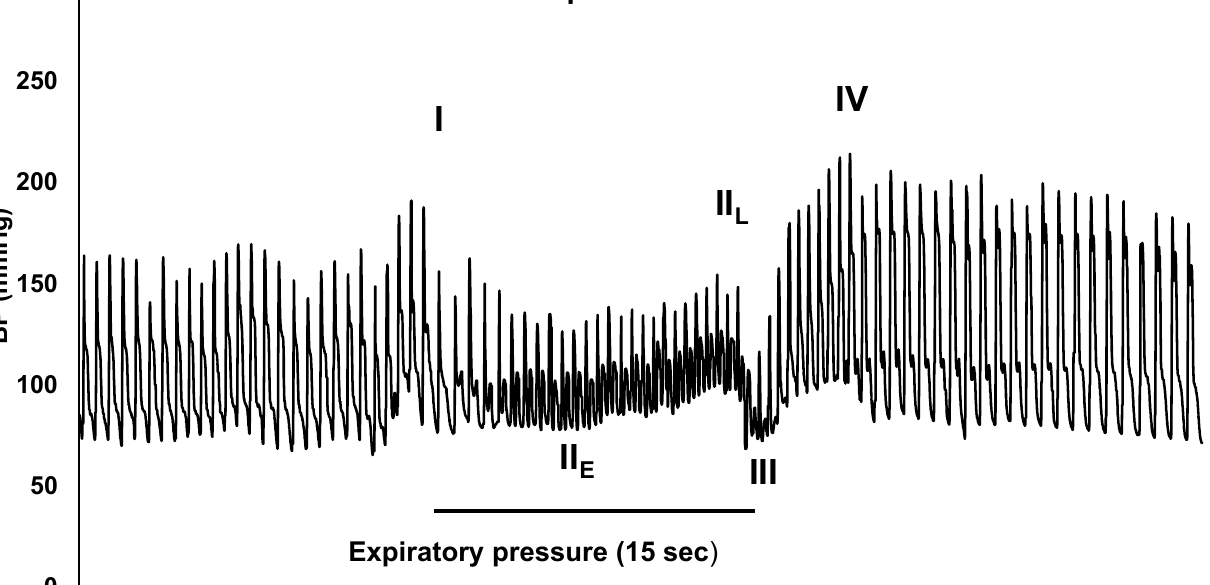
Figure 1. Beat-to-beat blood pressure (BP) response during the Valsalva maneuver. The VM consists of four main phases: phase I (I), early phase II (II E ), late phase II (II L ), phase III, and phase